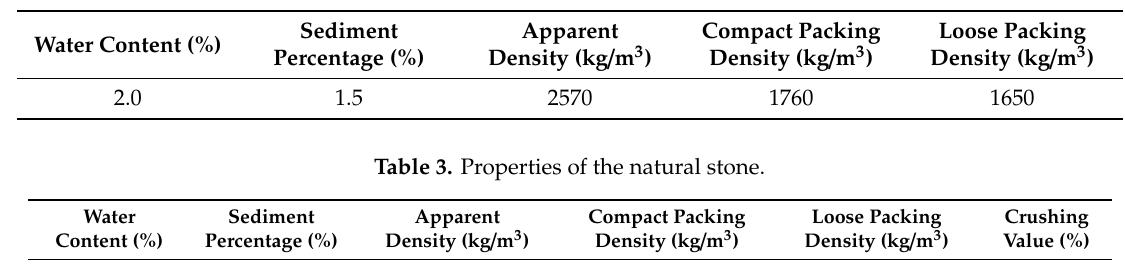
Table 2. Properties of the natural river sand.